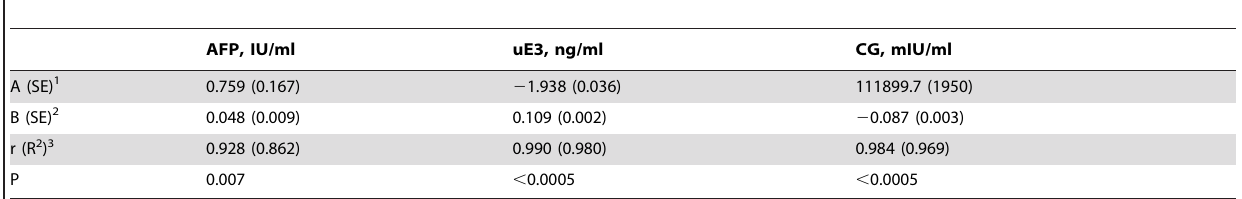
Table 2. Regression coefficients for the equations relating the three measured triple marker parameters to gestational age (in decimal weeks).